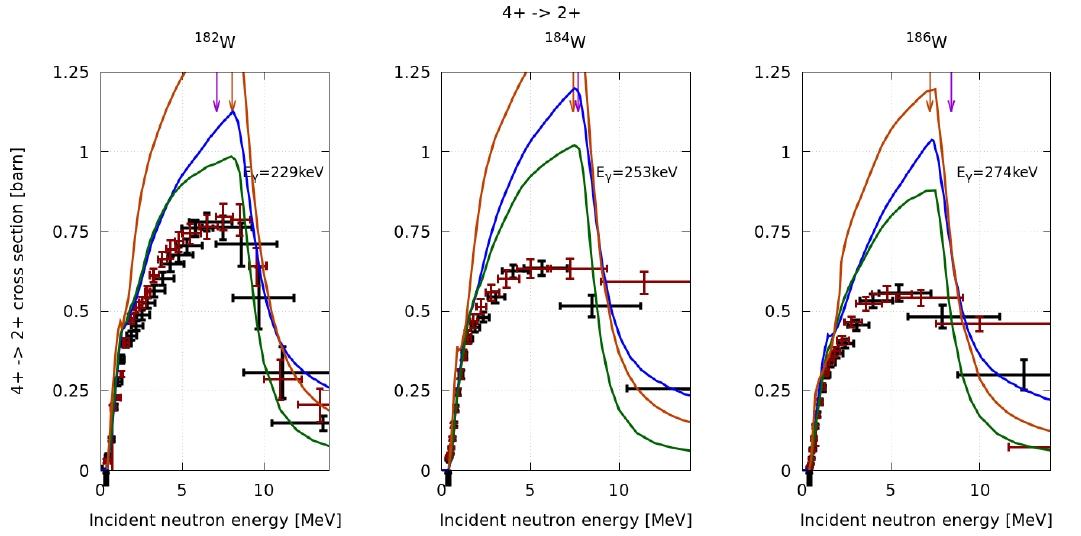
Figure 2. Same as figure 1, for the 4 + to 2 + transition in the ground state